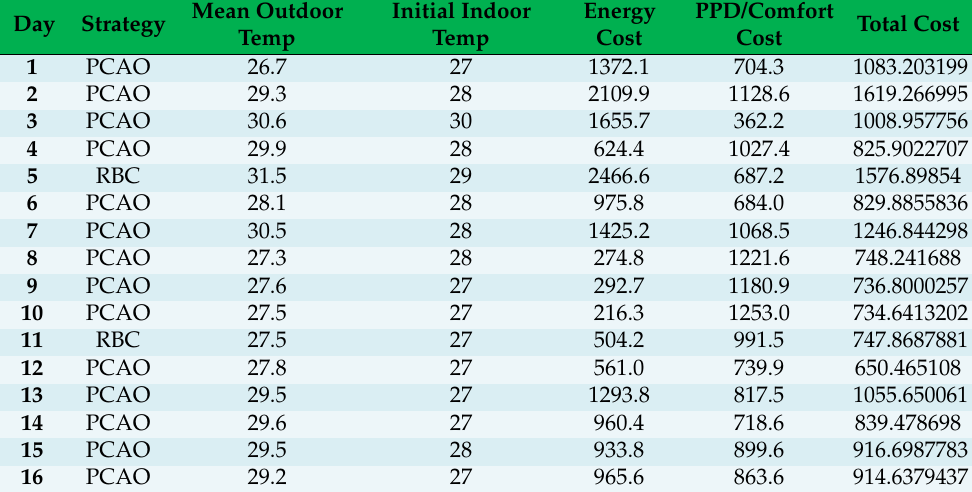
Table 3. Experiment results